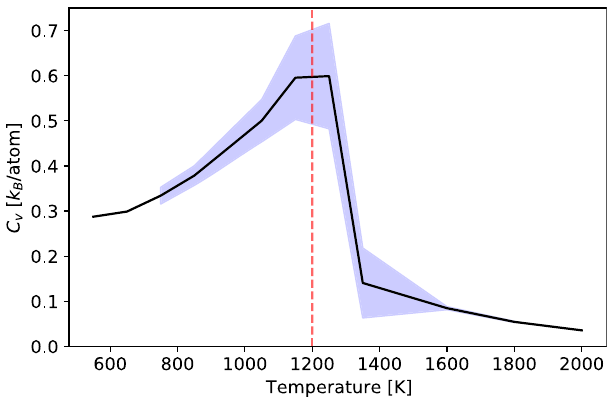
Fig. 1 Speci fi c heat capacity C V ( T ) for fcc TiZrNbHfTaC 5 from CMC simulations for a 10 × 12 × 15 simulation box. Vertical dashed line marks the probable phase transition. Blue shaded area indicates a standard deviation calculated from 40 independent runs for each